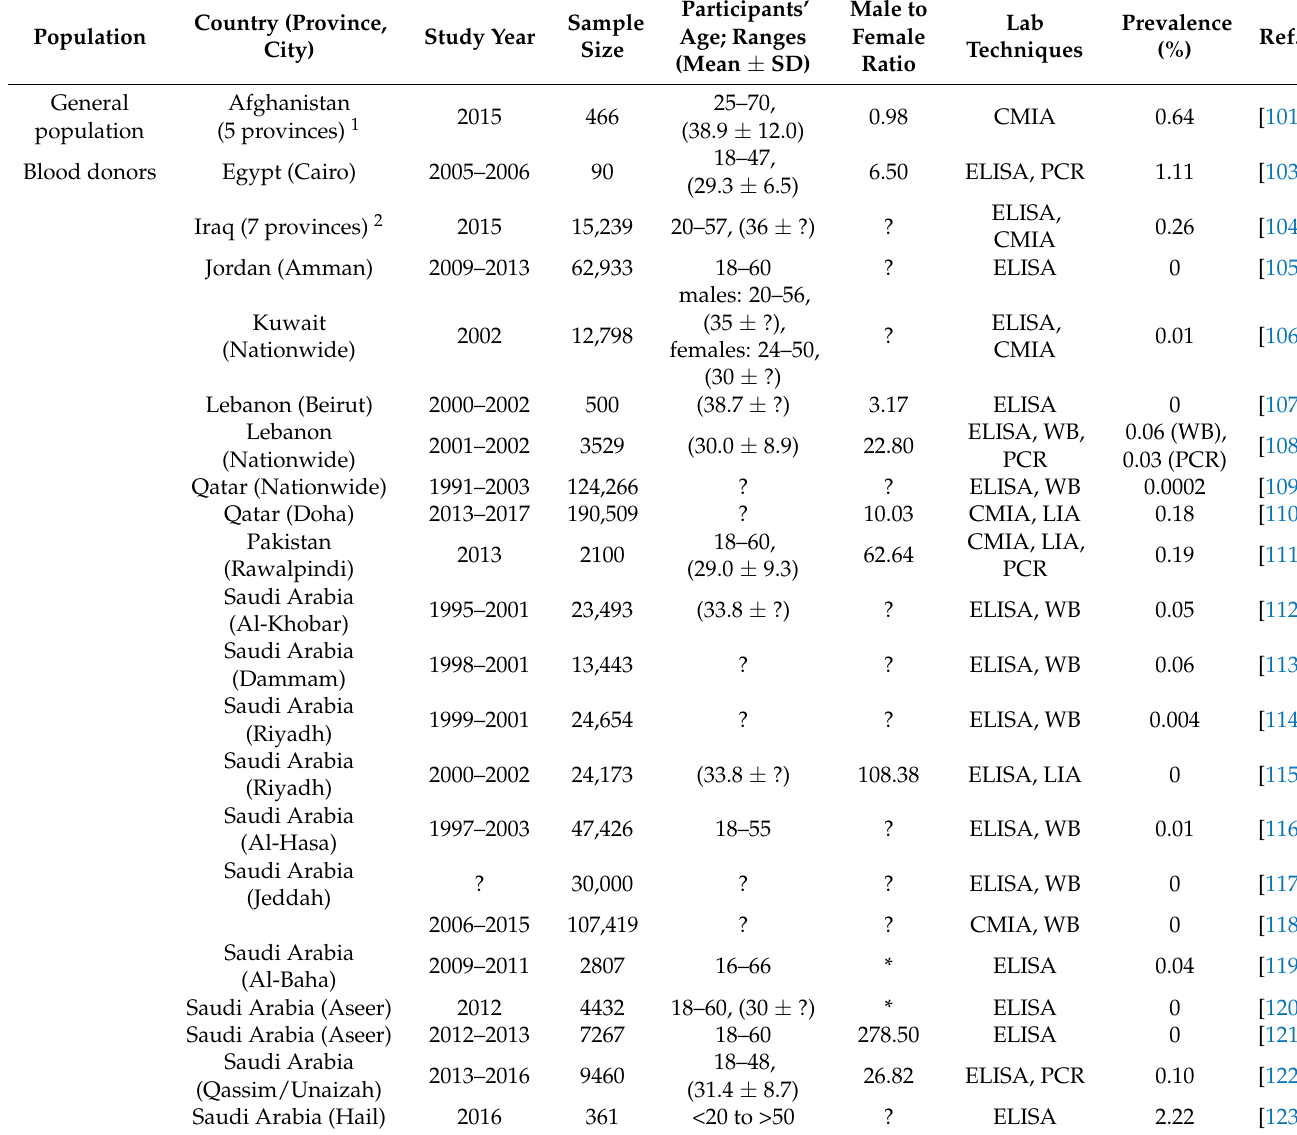
Table 3. Prevalence of HTLV-1 infection low- and high-risk populations of countries in the Eastern Mediterranean Regional Office of WHO (except Iran);